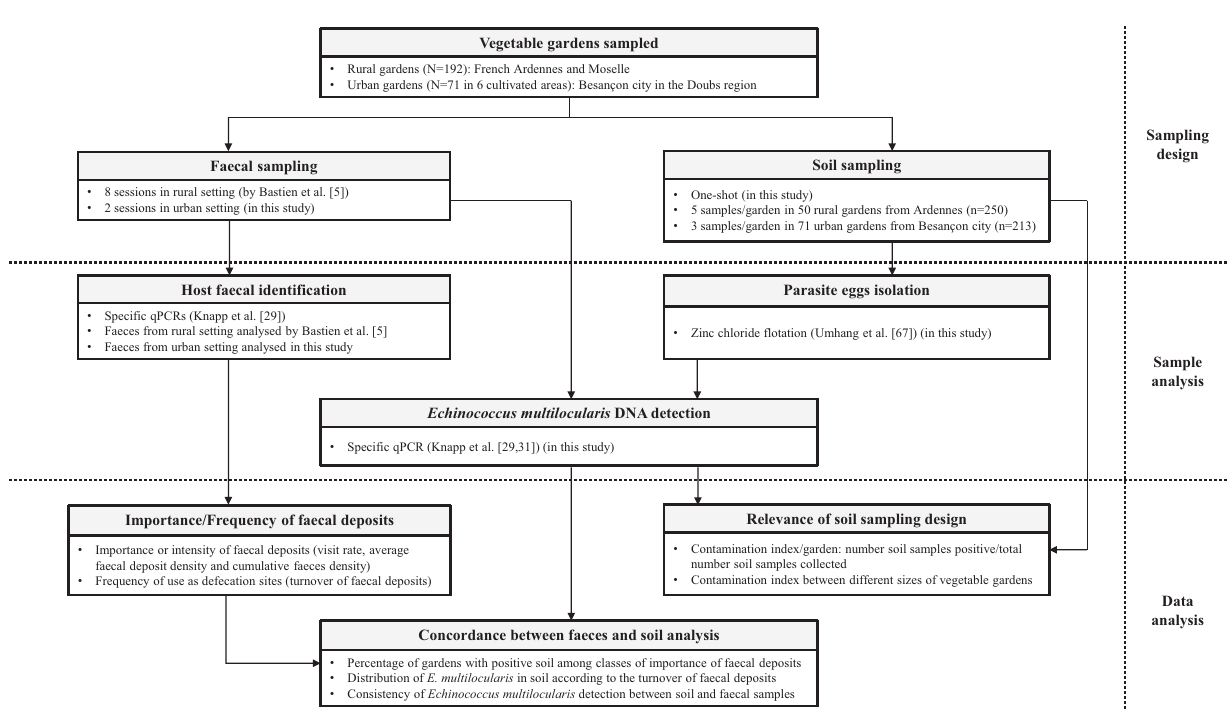
Figure 2. Process chart showing the collection and analysis of faeces and soil samples in rural and urban vegetable gardens located in E. multilocularis endemic regions of north-eastern